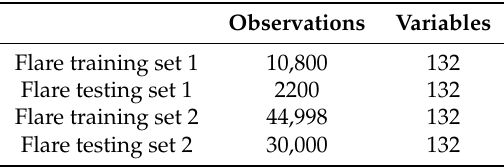
Table 4. Sizes of training and testing sets.